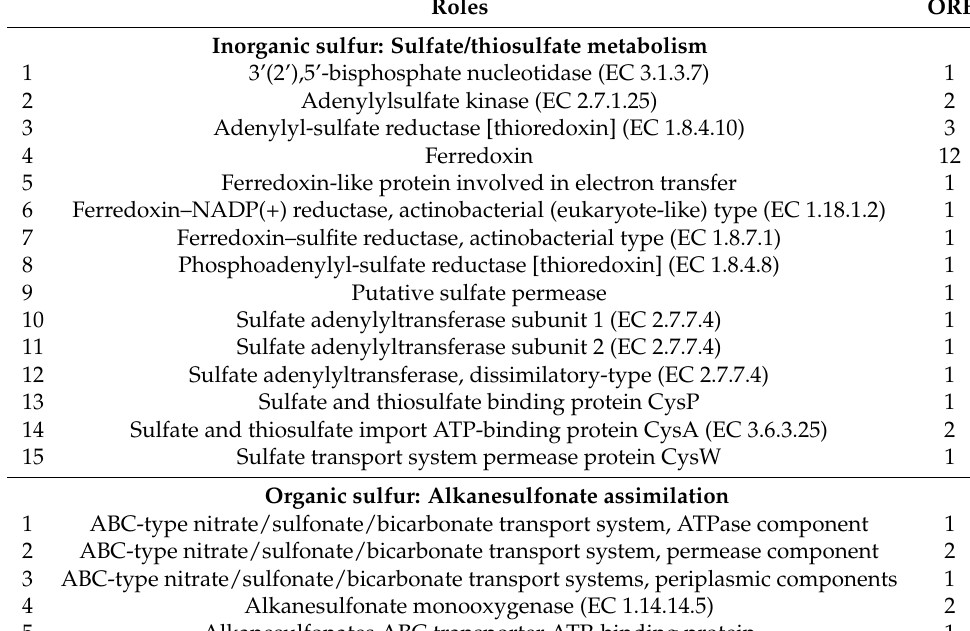
Table A4. Microtetraspora sp. AC03309 putative genes involved in sulfur assimilation annotated using RAST